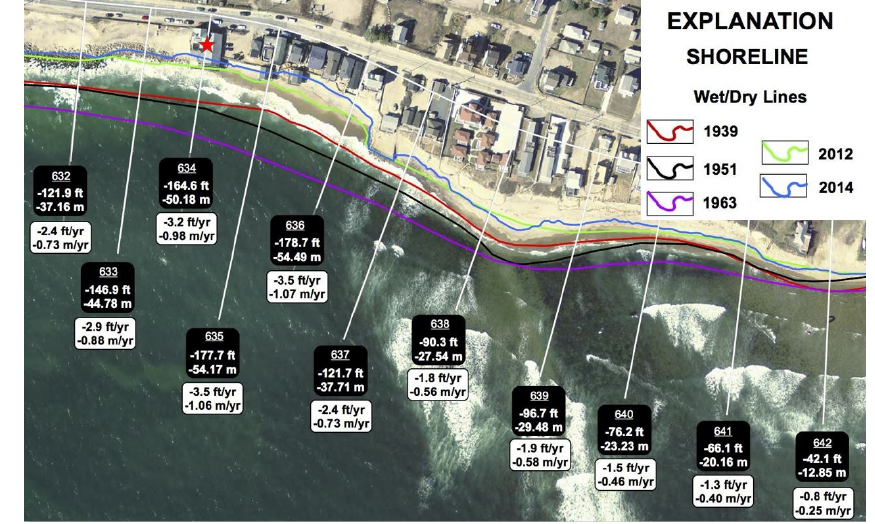
Figure 1. Site map of the coastal community of Matunuck, Rhode Island that was chosen for this study.